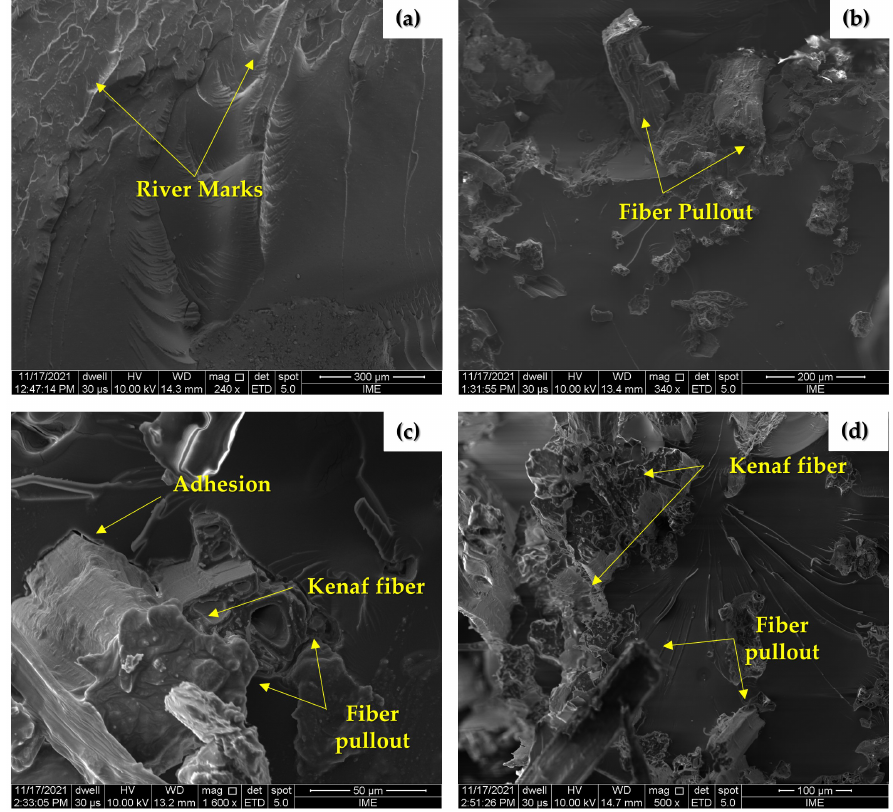
Figure 9. SEM images of fractured samples: ( a ) EPOXY; ( b ) EK10; ( c ) EK20; ( d )